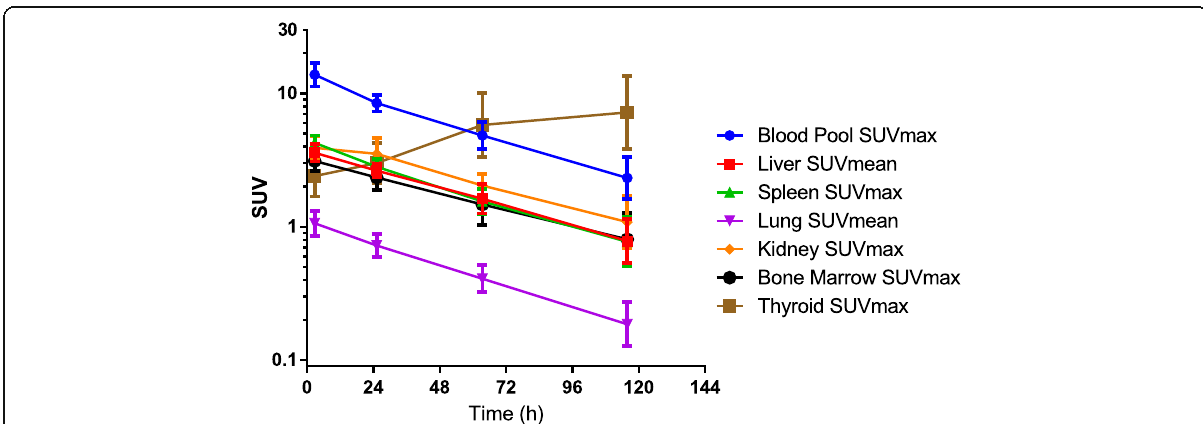
Fig. 3 Summary data from the baseline study in all patients receiving I-124 codrituzumab. VOIs were performed over the various organs and tissues. The amount of uptake was expressed in SUVmax or mean as indicated in the figure legend. The curves show that with the exception of the thyroid, which accumulates free I-124 over time, all other organs had a gradual decrease that was very similar to the clearance rate from the